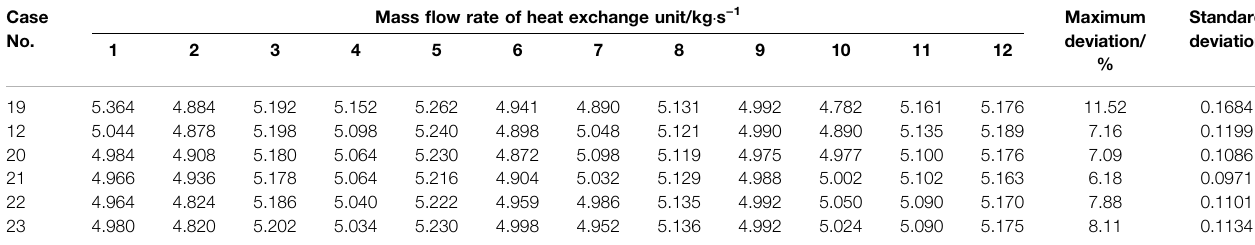
TABLE 8 | Numerical results of inter-unit fl ow rate distribution for fl ow homogenizers with different square hole row numbers. Case